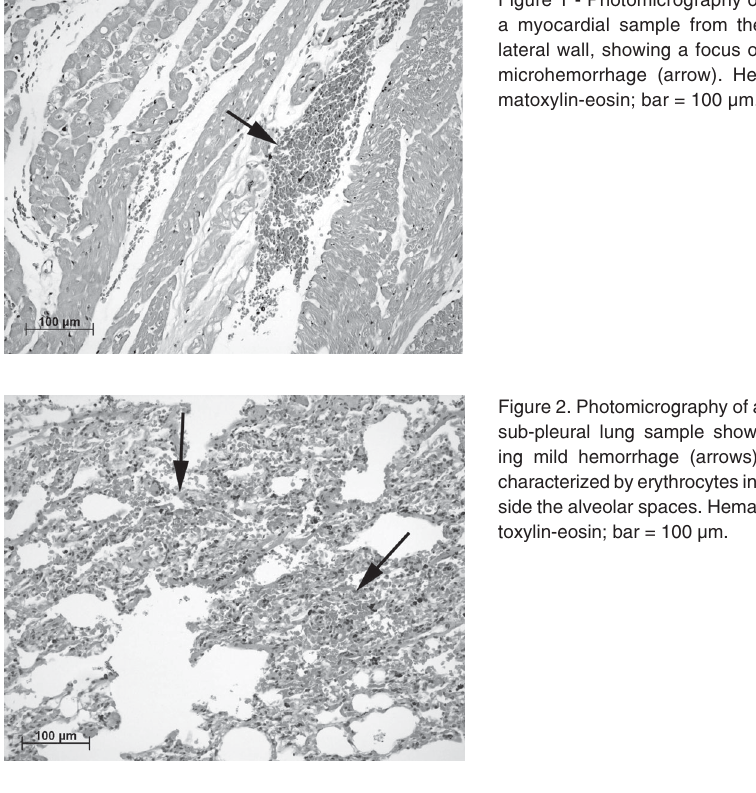
µm.Figure 1 - Photomicrography of a myocardial sample from the lateral wall, showing a focus of microhemorrhage (arrow). He- matoxylin-eosin; bar = 100